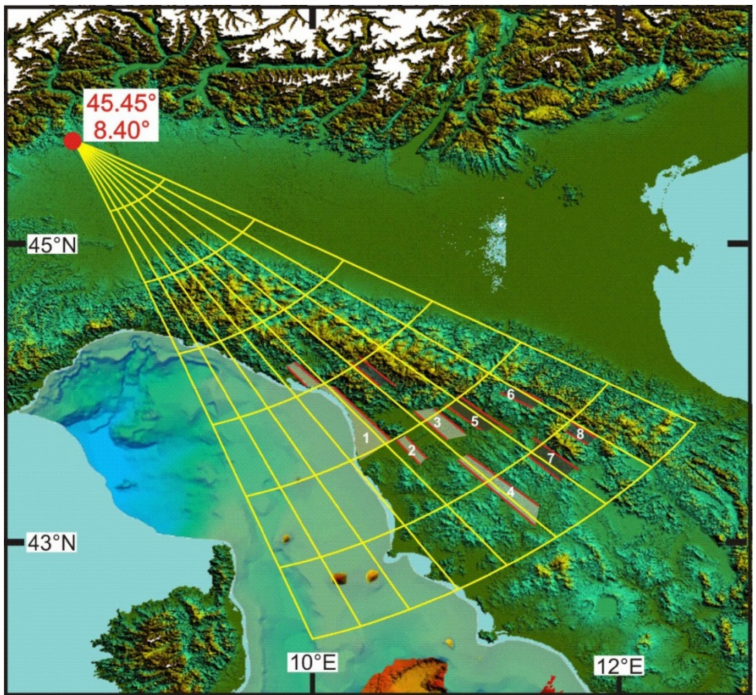
Figure 12. Morpho-structural lineaments of the northern Apennine and Euler pole of relative motion with respect to Sardinia-Corsica ( red dot ). The Euler pole grid shows the goodness of fit between kinematic model and geological structures. Some basins associated with the Tyrrhenian extension are also shown. Mio-Pliocene basins are in ( light gray ), Plio-Pleistocene basins are in ( dark gray ). (1) Viareggio basin, (2) Volterra basin, (3) Elsa basin, (4) Siena basin, (5) Firenze basin, (6) Mugello basin, (7) Valdarno basin, (8) Casentino